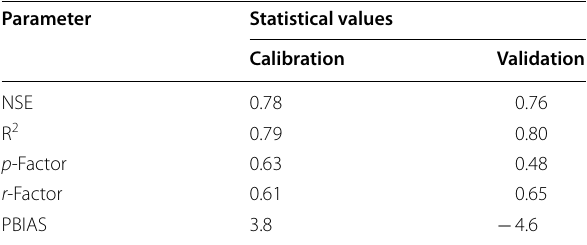
Table 5 SWAT model’s calibration and validation statistical